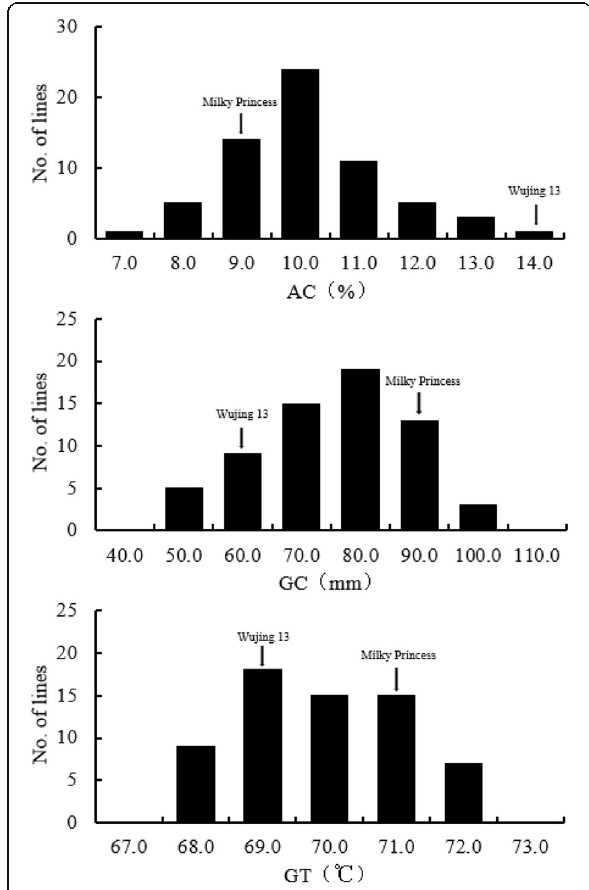
Fig. 4 Frequency distribution of the AC, GC, GT in 64 semi waxy